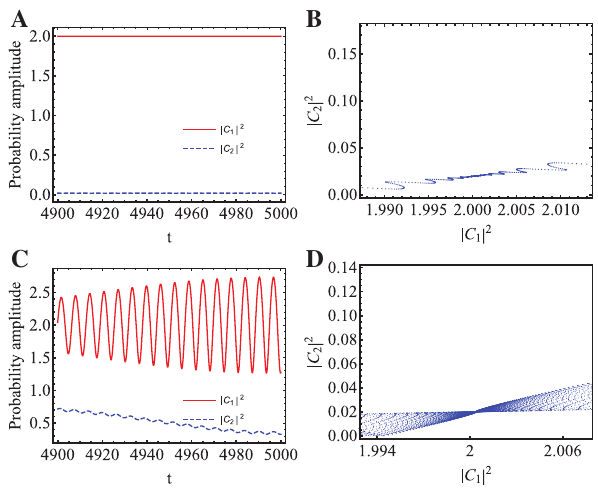
Figure 6: The evolution of the probability amplitude and the Poincare section under different coupling